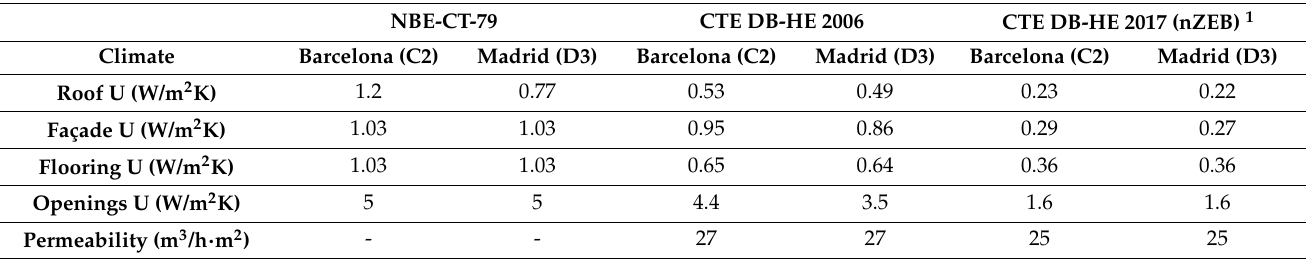
Table 2. Thermal transmittance according to the Spanish regulations of the year of application.